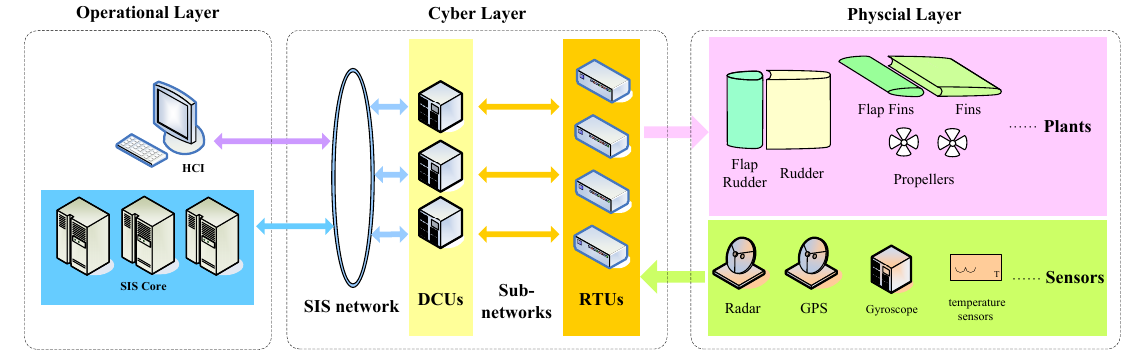
Figure 1. Interactions of a Ship Information System (SIS). DCU, Distributed Controller Unit; RTU, Remote Terminal